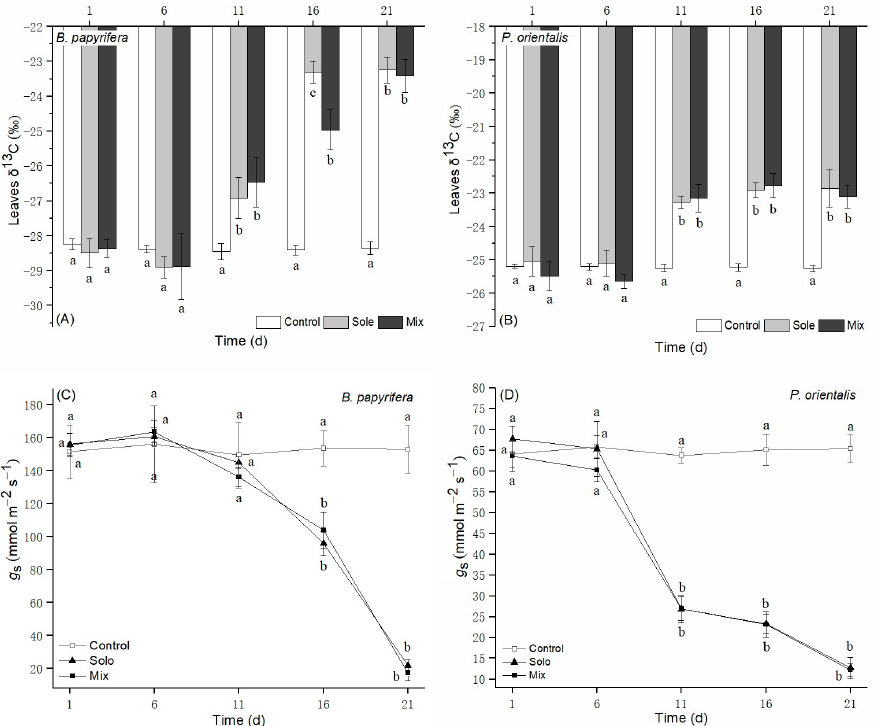
Figure 4. The leaves’ δ 13 C value in B. papyrifera ( A ) and P. orientalis ( B ). Leaves’ g s value in B. papyrifera ( C ) and P. orientalis ( D ). Letters denote significant differences among different planting and treatment modes ( p < 0.05).